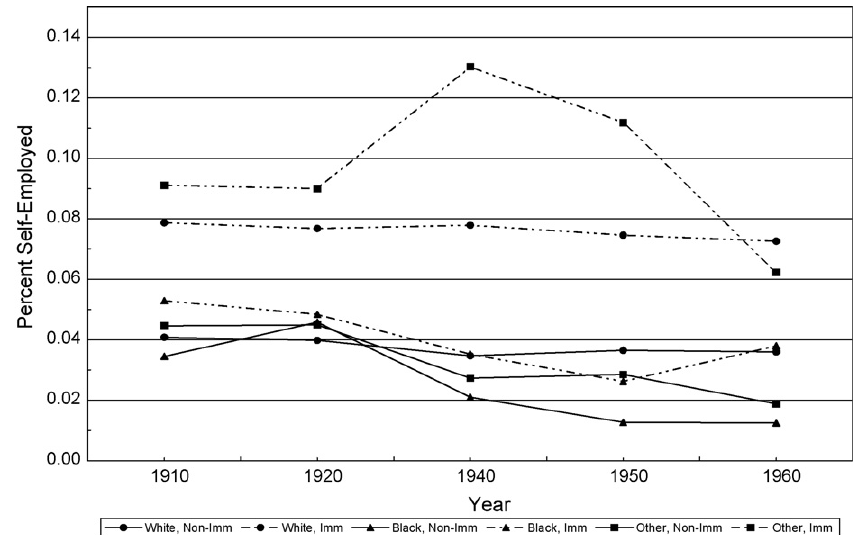
Fig. 3. U.S. self-employment rates: